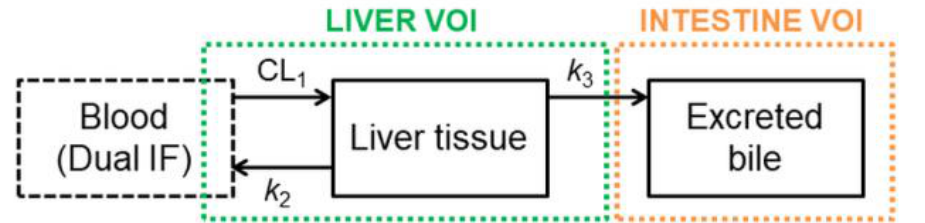
Figure 1. PK model used to assess the hepatobiliary disposition of [ 11 C]tariquidar, [ 11 C]erlotinib, and [ 11 C]elacridar. CL 1 (mL/min) represents the hepatic uptake clearance, and k 2 and k 3 (min − 1 ) are the rate constants describing the transfer of radioactivity from liver to the sink compartment (blood) and from liver to excreted bile (intestine volume of interest), respectively. The model was modified from a previously published model (Adapted from [28], AAPS, 2019). IF: input function; VOI: volume of interest.